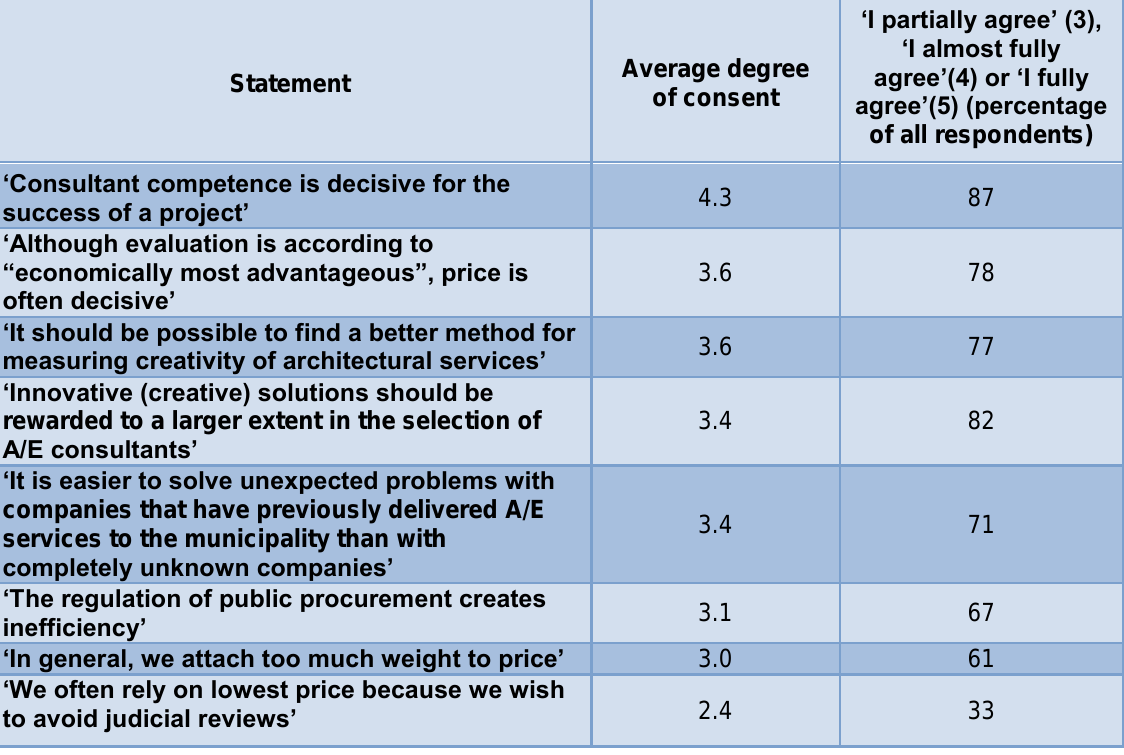
Table 1 Degree of respondent consent to a number of statements (five-degree scale, where 1 = I fully disagree and 5 = I fully agree)